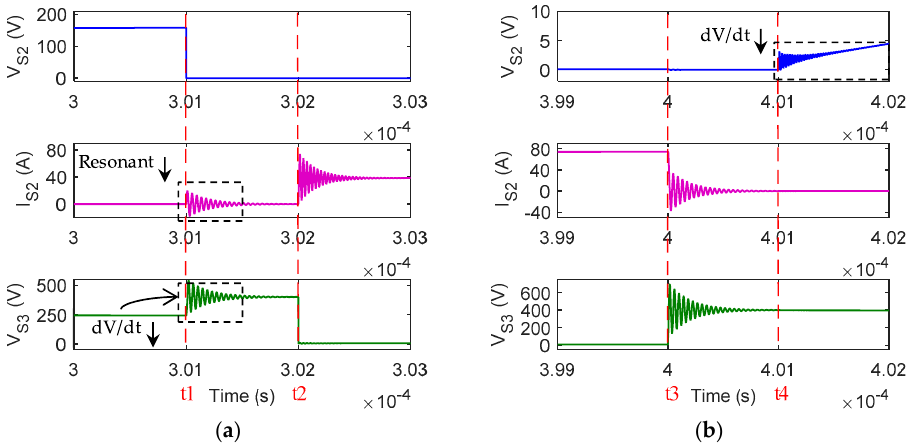
Figure 12. Simulation results of double pulse test for the hybrid switches with improved modulation ( a ) Zero Current Hard Voltage (ZCHC) turn-on; and, ( b ) Zero Current Zero Voltage (ZCZV) turn-off.